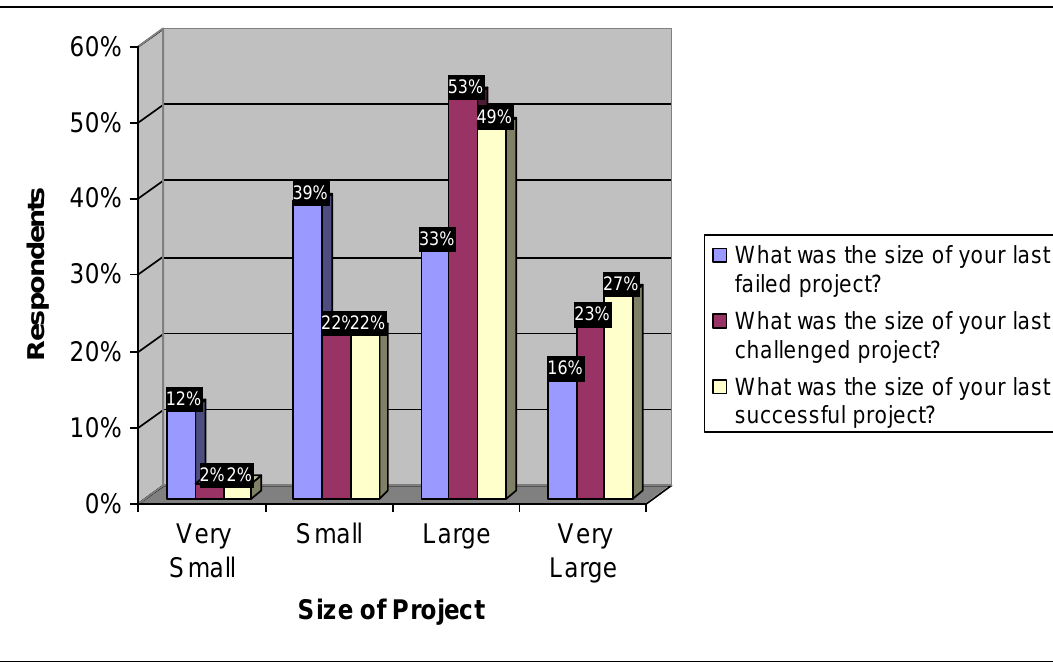
Figure 5: Project size in relation to project outcome